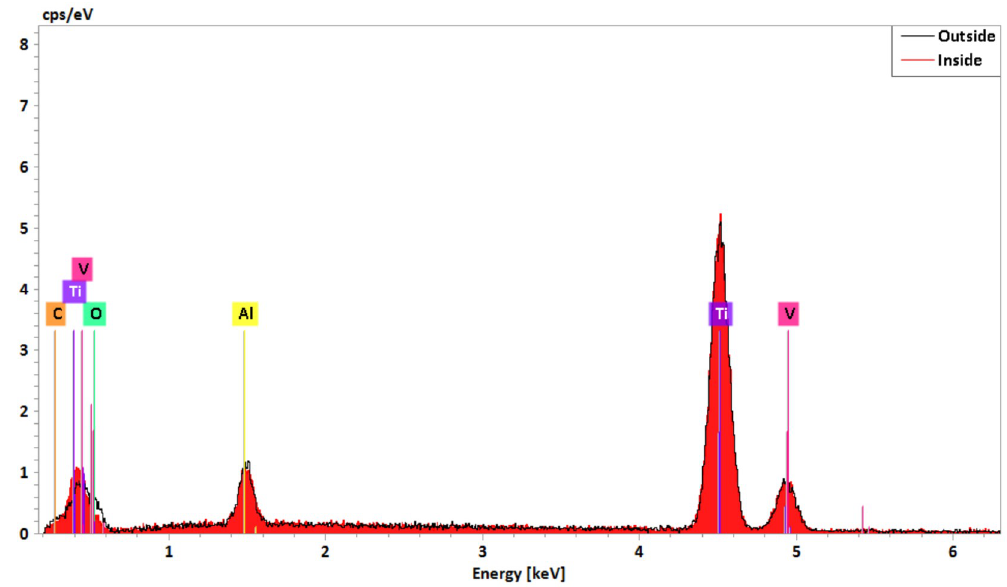
Figure 11. EDX analysis of the wear track of the 50 Hz and 10 mm s −1 treated sample.